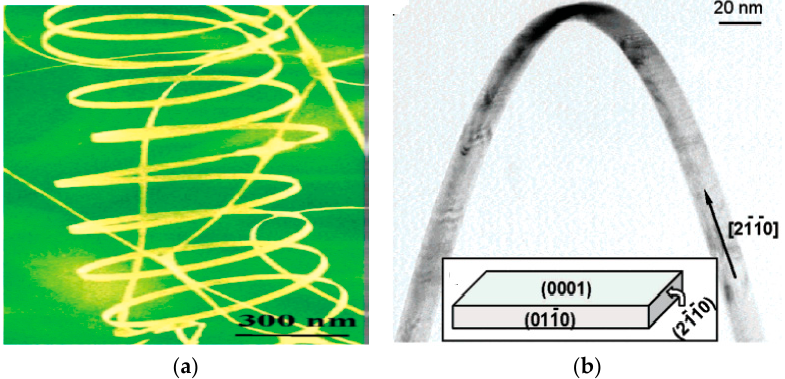
Figure 12. ( a ) SEM image of ZnO nanobelts. ( b ) Transmission electron micrograph of a helical nanobelt. Inset: structural model of ZnO nanobelt. Reproduced from [208] with permission of the American Chemical Society.